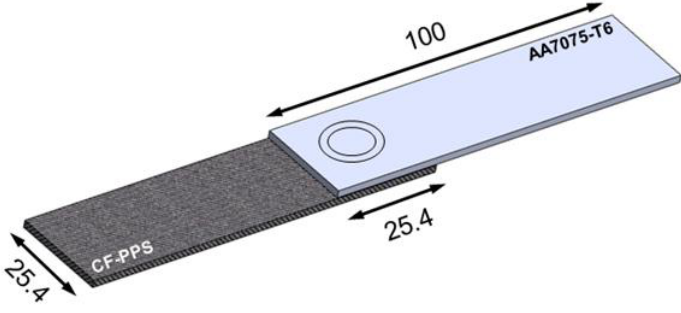
Figure 2. Configuration and dimensions of the joints (in mm).